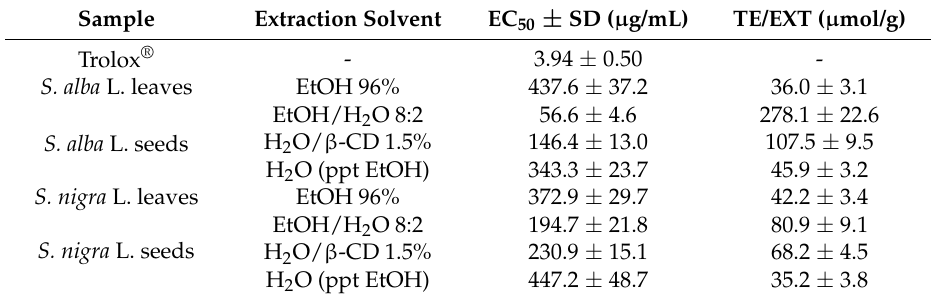
Table 2. Antioxidant activity of the various extracts compared with the Trolox ® standard expressed as EC 50 values (mean ± standard deviation) and as µ mol Trolox ® equivalents (TE) per g of extract